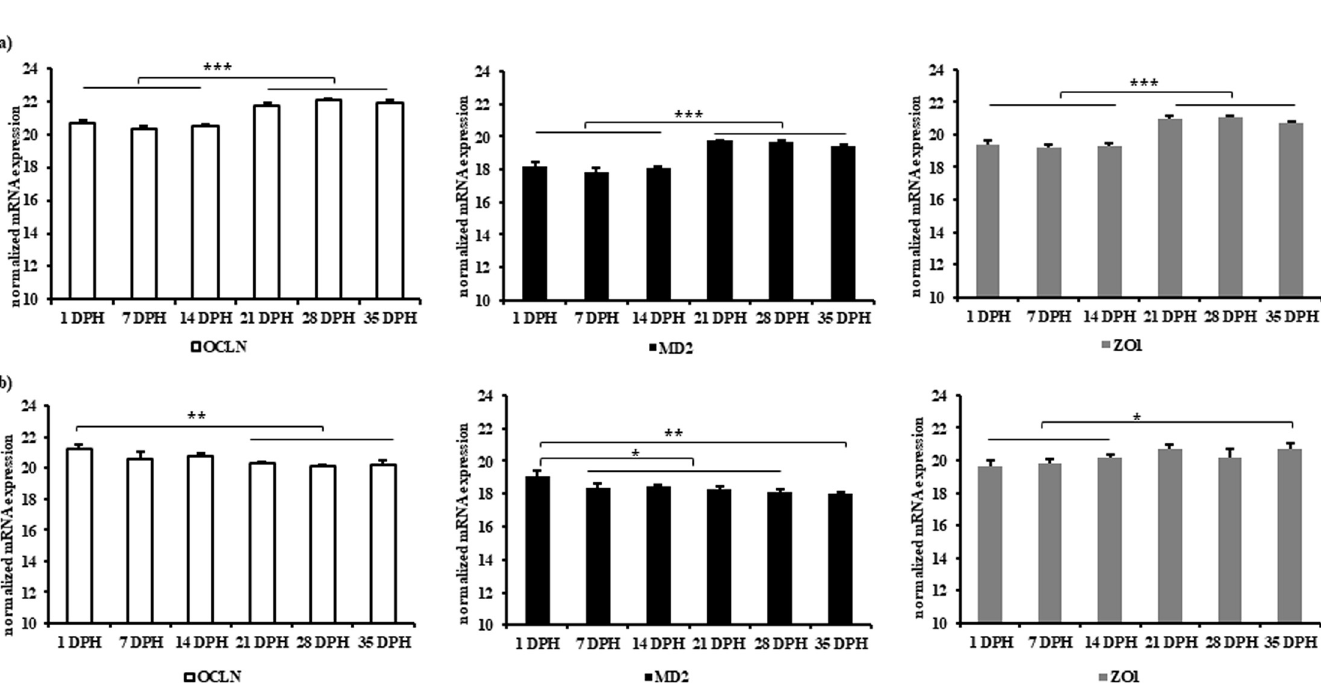
Fig 7. Normalized mRNA expression of OCLN, MD2 and ZO1 in (a) jejunum and (b) caecum at different age of broiler chickens. Results are presented as means with SEM (n = 5 birds). Statistical analysis was performed using ANOVA and Duncan’s test, � = P � 0.05, �� = P � 0.01, ��� = P � 0.001. Horizontal lines above the bars indicate no